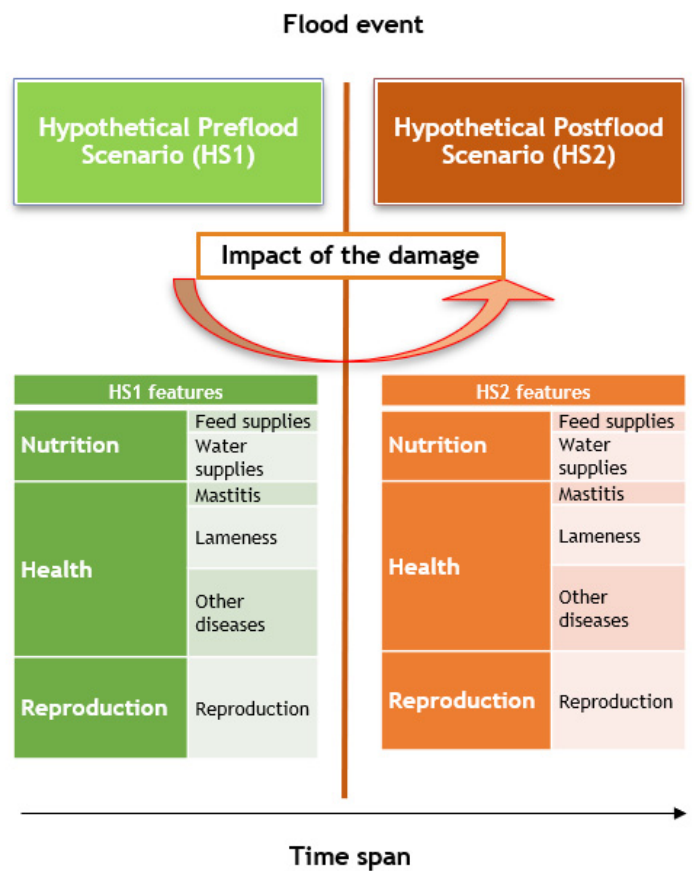
Figure 2. Scenario building method.